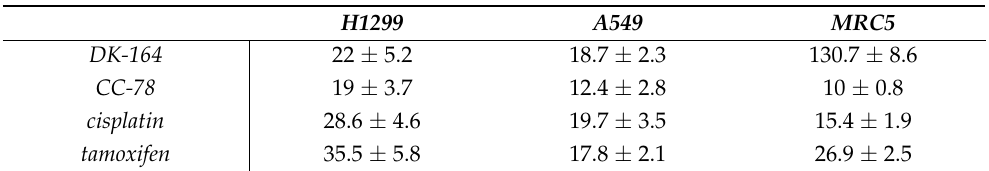
Table 1. Calculated IC50 [ μ M] values for DK ‐ 164, CC ‐ 78, and the chemotherapeutics cisplatin and tamoxifen. Data show mean ± SD from at least n = 3 independent experiments.